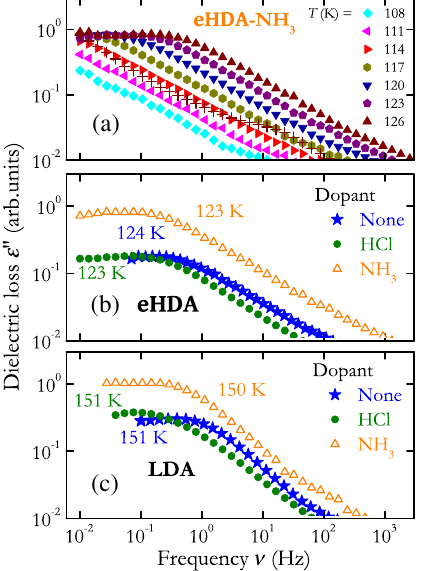
FIG. 5. (a) Frequency-dependent dielectric loss spectra of NH 3 -doped eHDA. For comparison, the crosses indicate the dielectric loss spectrum obtained at 129 K. It refers to NH 3 -doped LDA. Frame (b) shows loss spectra for undoped, HCl-doped, and NH 3 -doped eHDA. Frame (c) presents corresponding data for doped and undoped